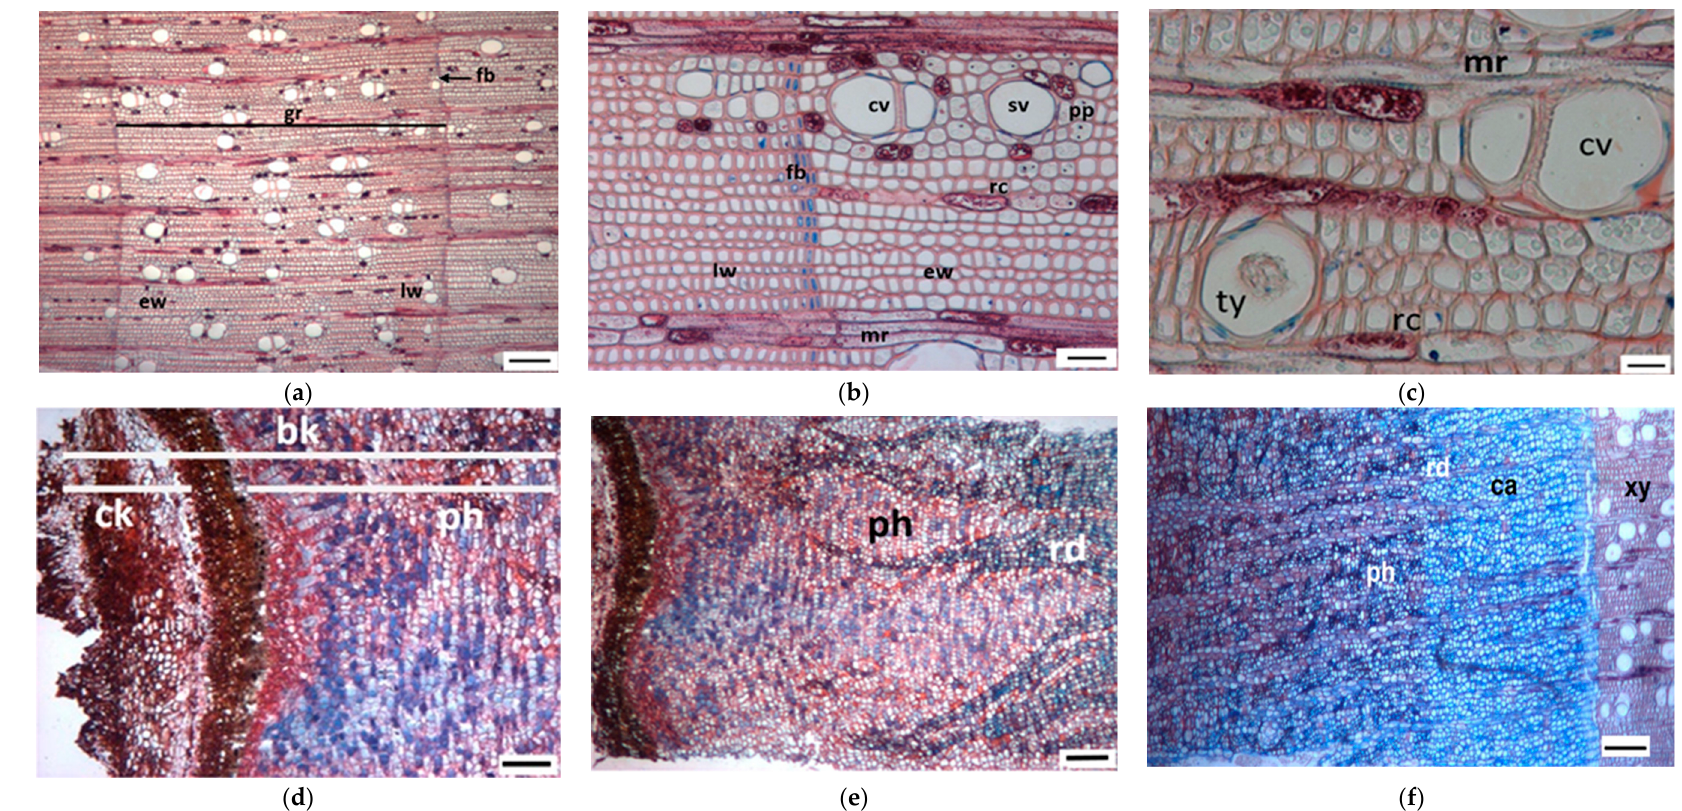
Figure 3. Cross-section view of L. azorica (Seub.) Franco tree rings under light microscope: First row: ( A ) General view of growth rings (gr) with thick-wall fibrous boundaries (fb), earlywood (ew) and latewood (lw), xylem rays and vessels with equal size and distribution along annual ring (scale bar 200 µm); ( B ) Growth ring boundary (fb), paratracheal parenchyma cells around vessels (pp), multiseriate rays (mr), solitary vessels (sv), clustered vessels (cv) and reddish cells (rc) (scale bar 50 µm); and ( C ) Unlignified tylosis (ty) (scale bar 25 µm). Second row: ( D , E) , cross section view of bark with phloem wood: ( D ) Simple construction of phloem, with phloem elements difficult to distinguish but differentiated from ray dilatation (scale bar 150 µm); ( E ) Bark layers. rd—ray dilatation; ph—phloem; ck—cork layers; bk—bark (scale bar 200 µm); ( F ) Cross-section of cambial zone from L. azorica , cambium is crossed by xylem rays that dilate in phloem to the bark. xy—xylem; ca—cambium; ph—phloem; rd—ray dilatation (scale bar 200 µm).